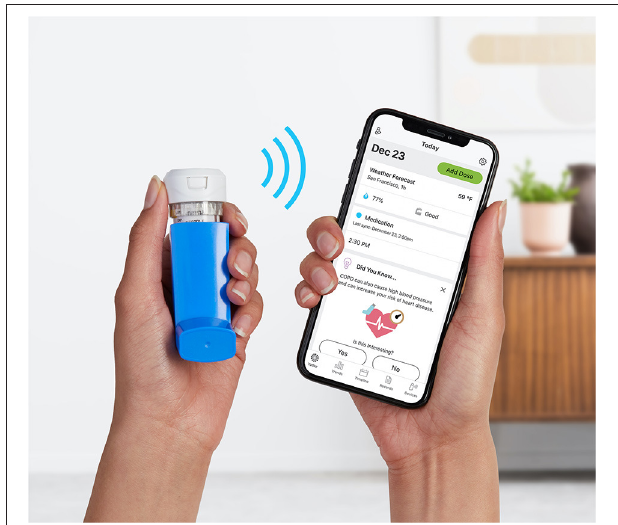
FIGURE 1 | A small electronic medication monitor (EMM) attaches to a metered dose inhaler (MDI) to collect data on inhaler usage. Data is then transmitted wirelessly via Bluetooth to a paired patient-facing smartphone